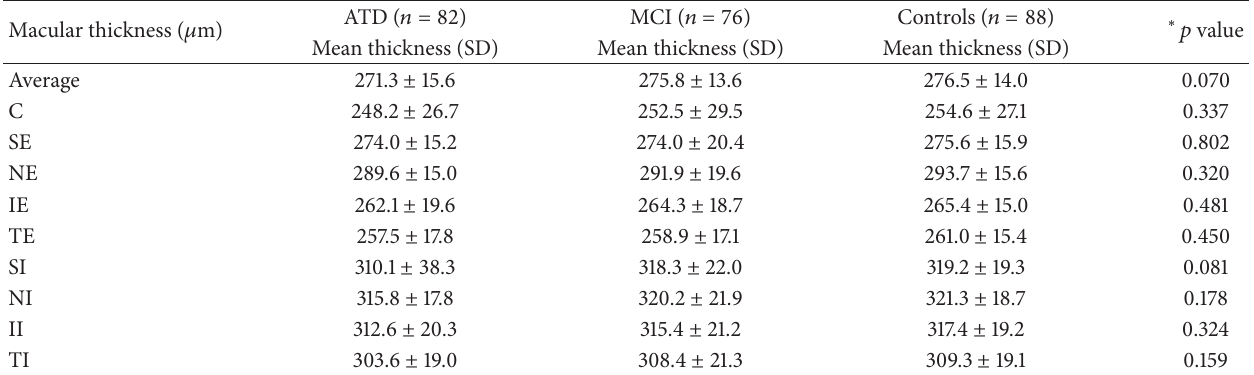
Table 4: Comparison of macular thickness among the study